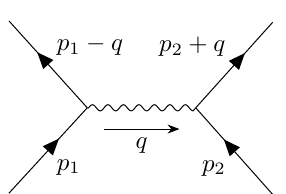
Figure 1. Classical scattering of two particles at